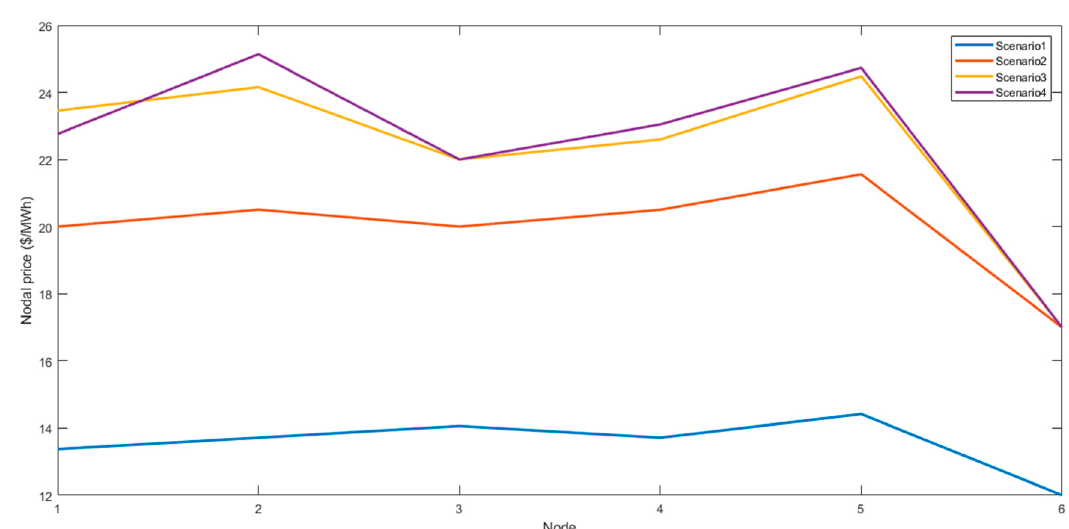
Figure 5. Nodal price with